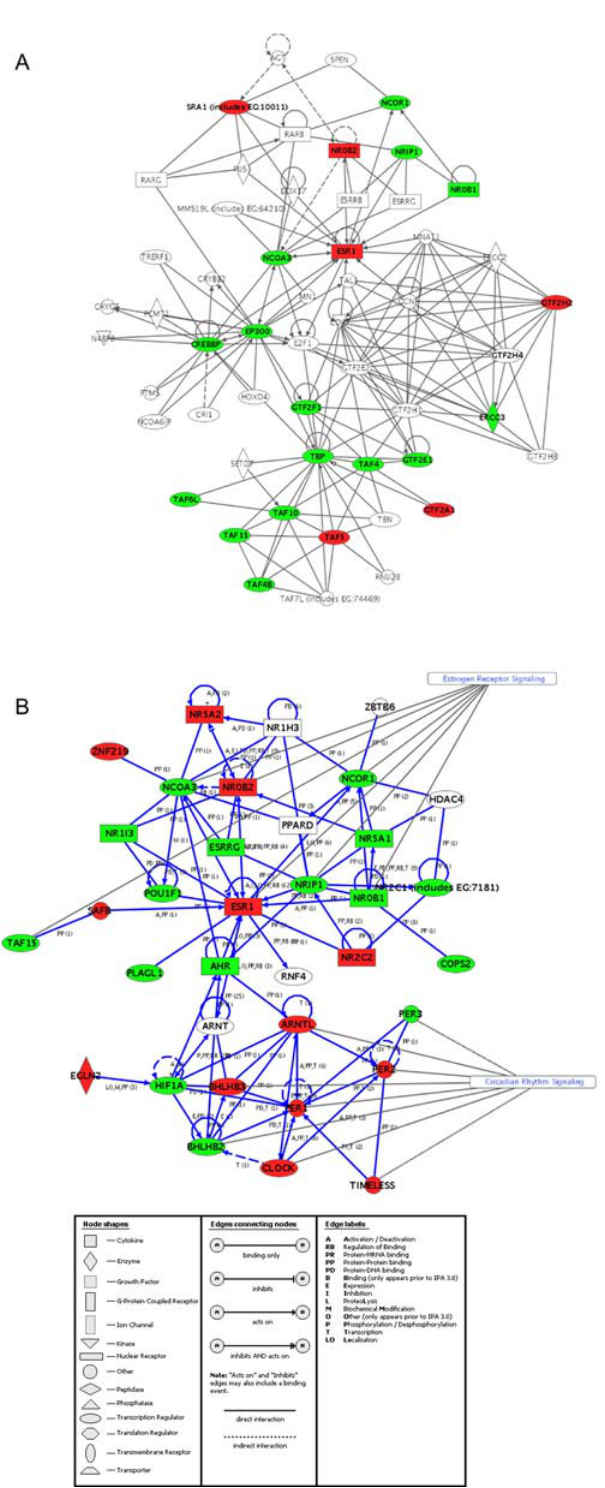
Figure 5. Two examples of Ingenuity gene networks constructed from cochlear differentially expressed genes. Genes that showed differential expression in both the laser and neomycin cochlear time courses (listed in Supplementary Tables S6 and S8) were uploaded to the web-based Ingenuity program (Ingenuity H Systems, www.ingenui- ty.com) and the network of interactions shown here was generated. Each interaction is shown according to the following legend and is supported by at least one literature citation (available from the Ingenuity website). Figure 5A shows the network of interactions